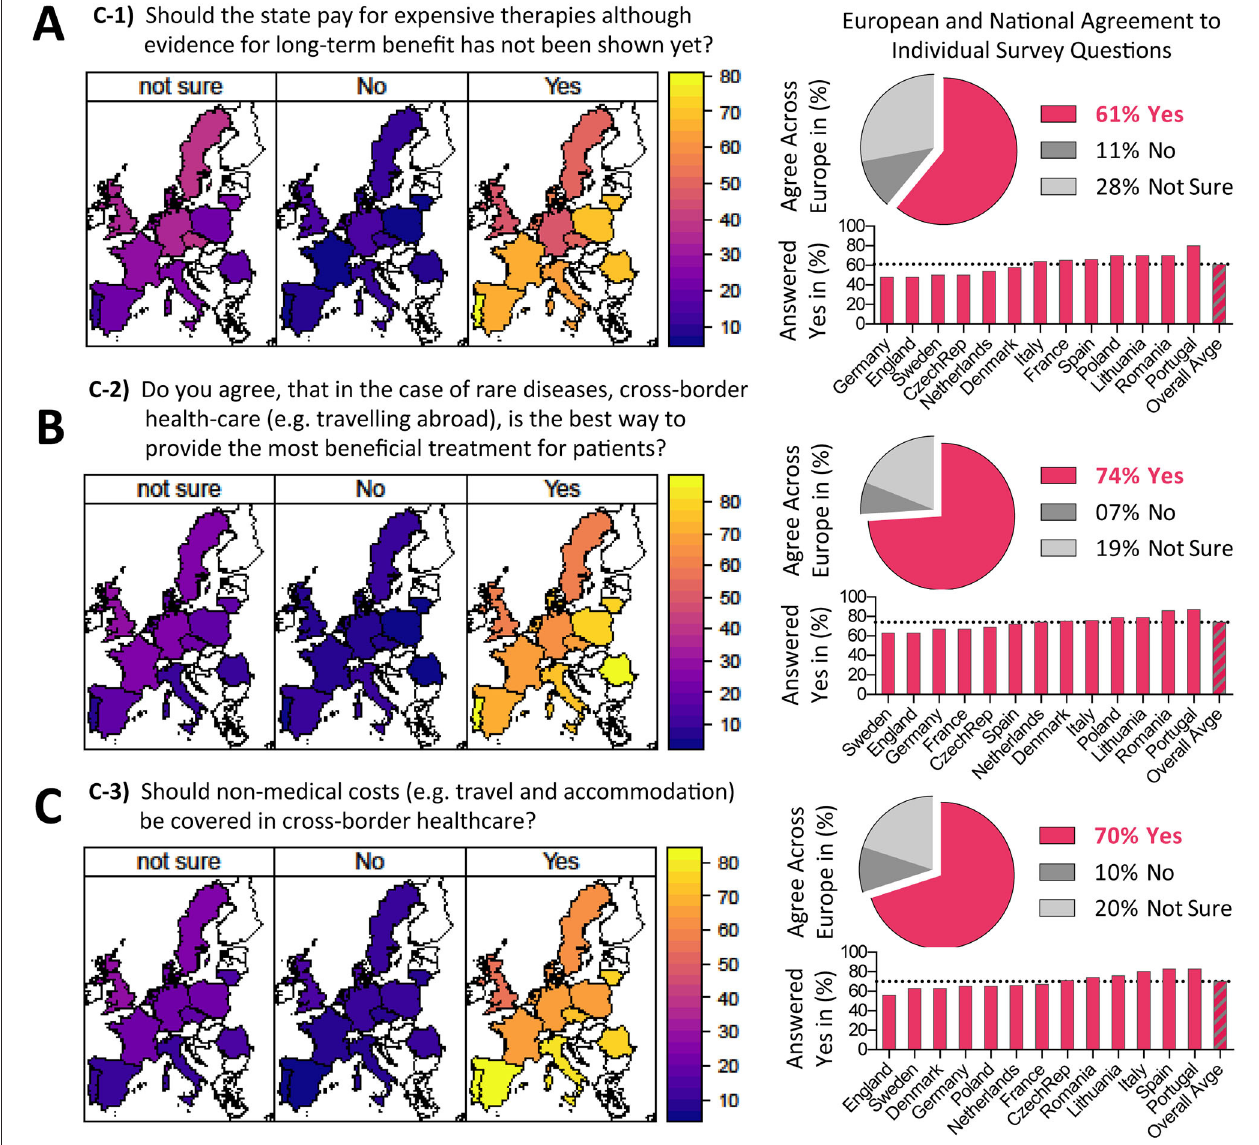
FIGURE 4 | Opinions on reimbursement of ATMPs. (A–C) Results on survey topic C sorted according to questions C1-C3, with geographical heatmaps shown to the left and corresponding numerical depiction shown to the right, with pie charts displaying the (%) agreement across Europe and bar charts displaying (%) answered yes per country. Only 61% of European citizens agree that the state should pay for expensive therapies although evidence for long-term benefit has not been shown yet, while 74% agree that in the case of rare diseases cross-border health-care (e.g. traveling abroad) is the best way to provide the most beneficial treatment for patients, and 70% agree that non-medical costs (e.g. travel and accommodation) should be covered in cross-border healthcare, clearly indicating that a majority of European citizens is in support of European cross-boarder health care for rare diseases and for support for non-medical costs, such as travel and